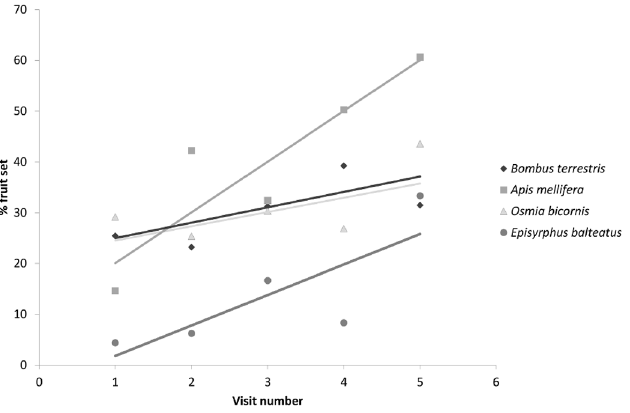
Fig 1. Percentage fruit set of apples (var Scrumptious) following different per flower visit numbers by four pollinator species.